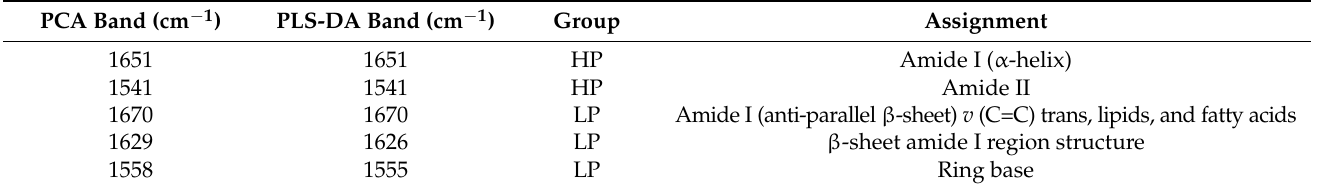
Table 5. Prominent ATR-FTIR exosome spectral bands for discrimination of the LP and HP groups using PCA and PLS-DA